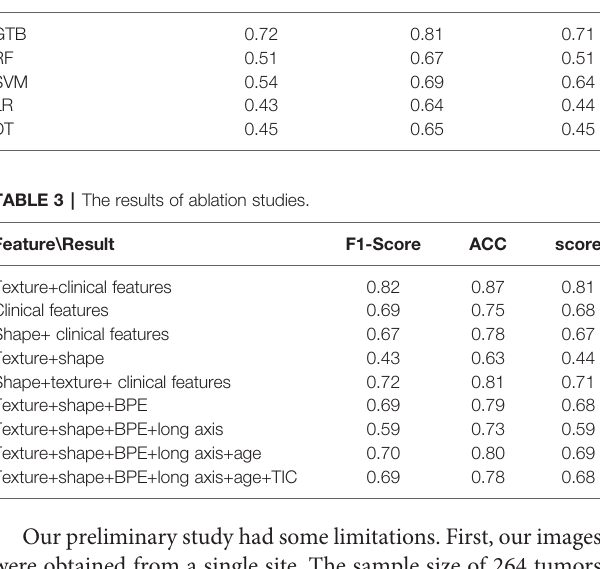
TABLE 2 | The classi fi cation results of the fi ve classi fi ers. Method\Result